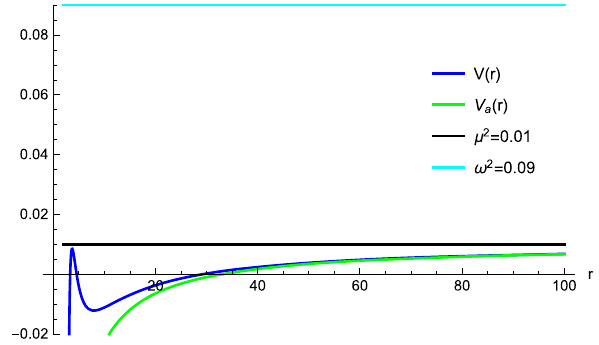
Fig. 5 Potential V ( r ) as function of r with M = 1 , Q = 0 . 2 ,ω = 0 . 3 , a = 0 . 1 , m = 1 , q = 0 . 1 ,λ lm = 2 ,μ = 0 . 1 for r ∈ [ r + = 1 . 975 , 100 ] . The potential is negatively singular at r = r + with a neg- ative well. V a ( r ) mimics V ( r ) for r ≥ 40 but V ( r ) < ω 2 and ω > μ